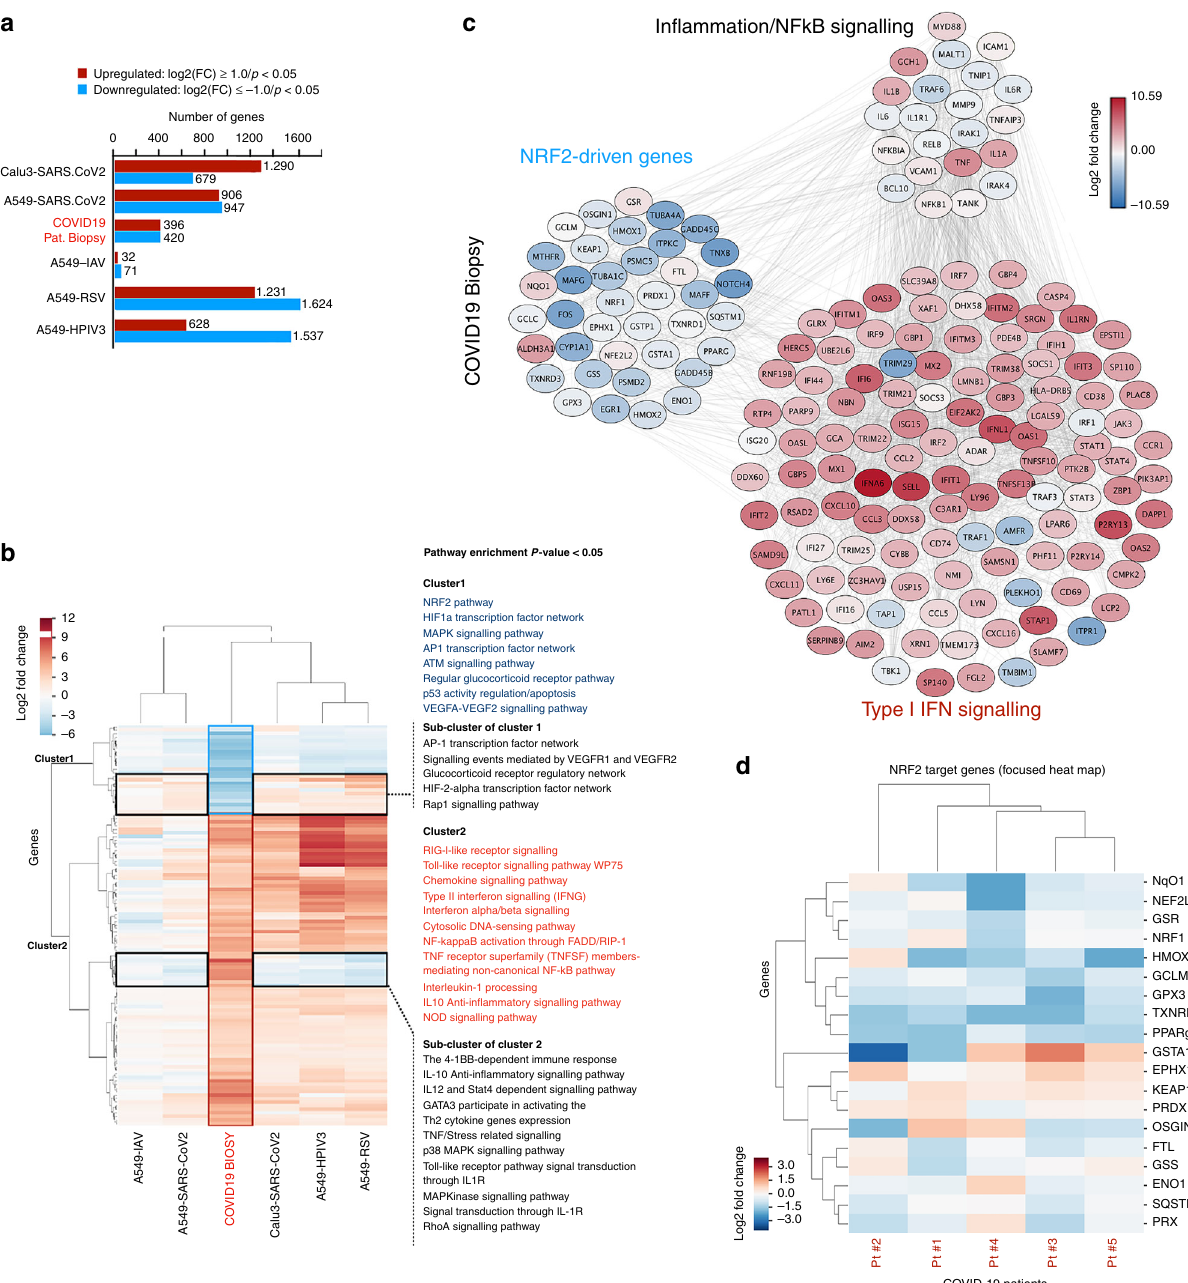
Fig. 1 Expression of NRF2-driven genes is suppressed in COVID-19 patient biopsies. a , b , c Reanalysis of data published by Blanco-Melo et al. 14 ( a ) Bar- chart of the number of transcripts showing signi fi cant differential expression (adjusted p value < 0.05 and log2(FC)> 1.0). Data from COVID19 lung biopsies was normalized against healthy lung biopsies, and in cell lines Calu3, NHBE, and A549 infected with either SARS-CoV2, In fl uenza A virus (IAV), Respiratory Syncytial virus (RSV), or human parain fl uenza virus type 3 (HPIV3) against mock treated cells. Expression and p values were calculated with DESeq2 using Wald test statistic and Benjamini-Hochberg correction for multiple testing. b Heat map of the subset of genes signi fi cantly differentially expressed in COVID19 biopsies and simultaneously differentially expressed in at least 3 of the other conditions tested. The genes in each cluster were used for pathway enrichment analysis. Genes in cluster 1 are dominantly down-regulated in COVID19 biopsies while a sub-cluster of genes in cluster 1 are up- regulated in the cell lines. Conversely, genes in cluster 2 are predominantly up-regulated in biopsies and in most other test-samples. A subcluster of the genes in cluster 2 are down regulated in the cell lines. For each cluster, the signi fi cantly enriched pathways are listed (EnrichR). c Cloud analysis of NRF2- driven differentially expressed genes. Subsets annotated as in fl ammation/NF κ B signaling and Type I IFN signaling exhibit different expression patterns. The experiment is a reanalysis of data from Blanco-Melo et al. [https://doi.org/10.1101/2020.03.24.004655]. d Reanalysis of the data from Desai et al. 15 GEO accession code GSE150316. Heat map of NRF2 target genes of the lung autopsies from the fi ve COVID19 patients. Healthy lung samples were used as negative